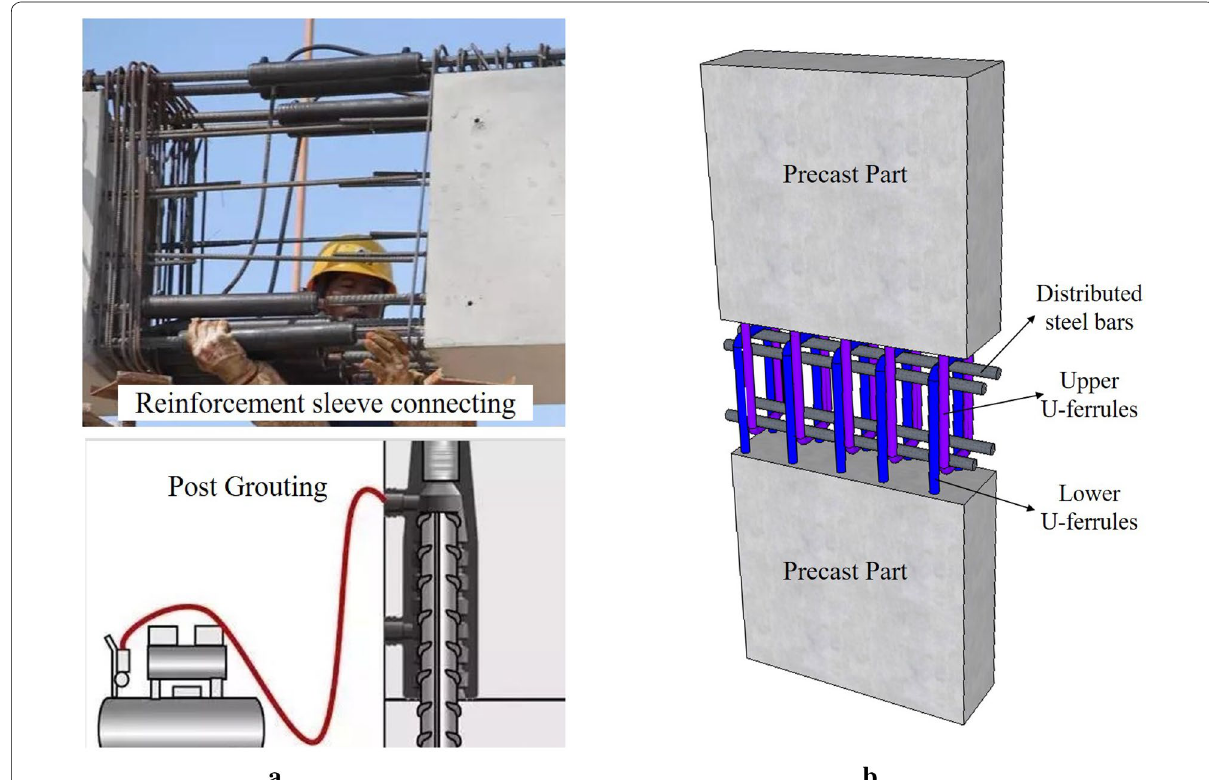
Fig. 1 Construction details of the grouted sleeve connection and previous U-type reinforcement ferrule connection: a the grouted sleeve connection; b the U-type reinforcement ferrule